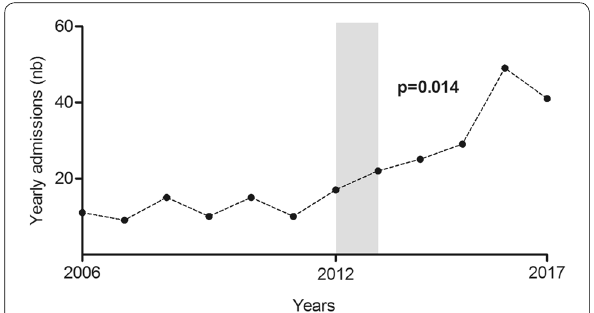
Fig. 1 Yearly admissions to our center for necrotizing soft tissue infections (dotted line). The grayed area represents the implementation period of our bundle of care. p value for a Mann– Whitney test comparing yearly admissions for NSTI between